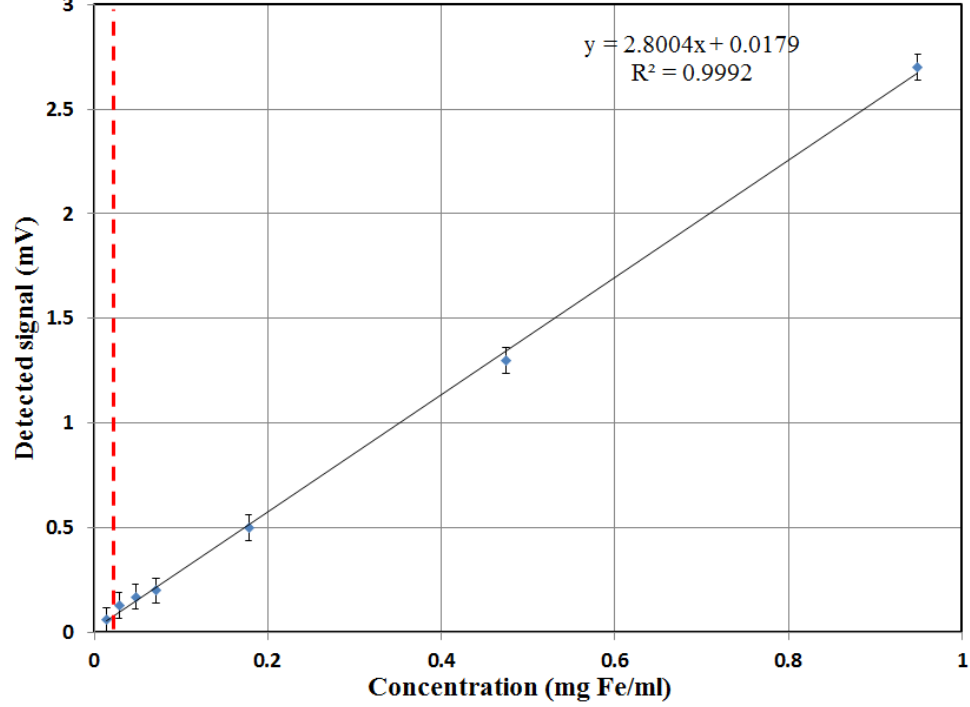
Figure 7. Magnetic response as a function of the mass concentration of 20 nm iron oxide (Fe 2 O 3 ) nanoparticles. The red dotted line indicates the calculated limit of detection.